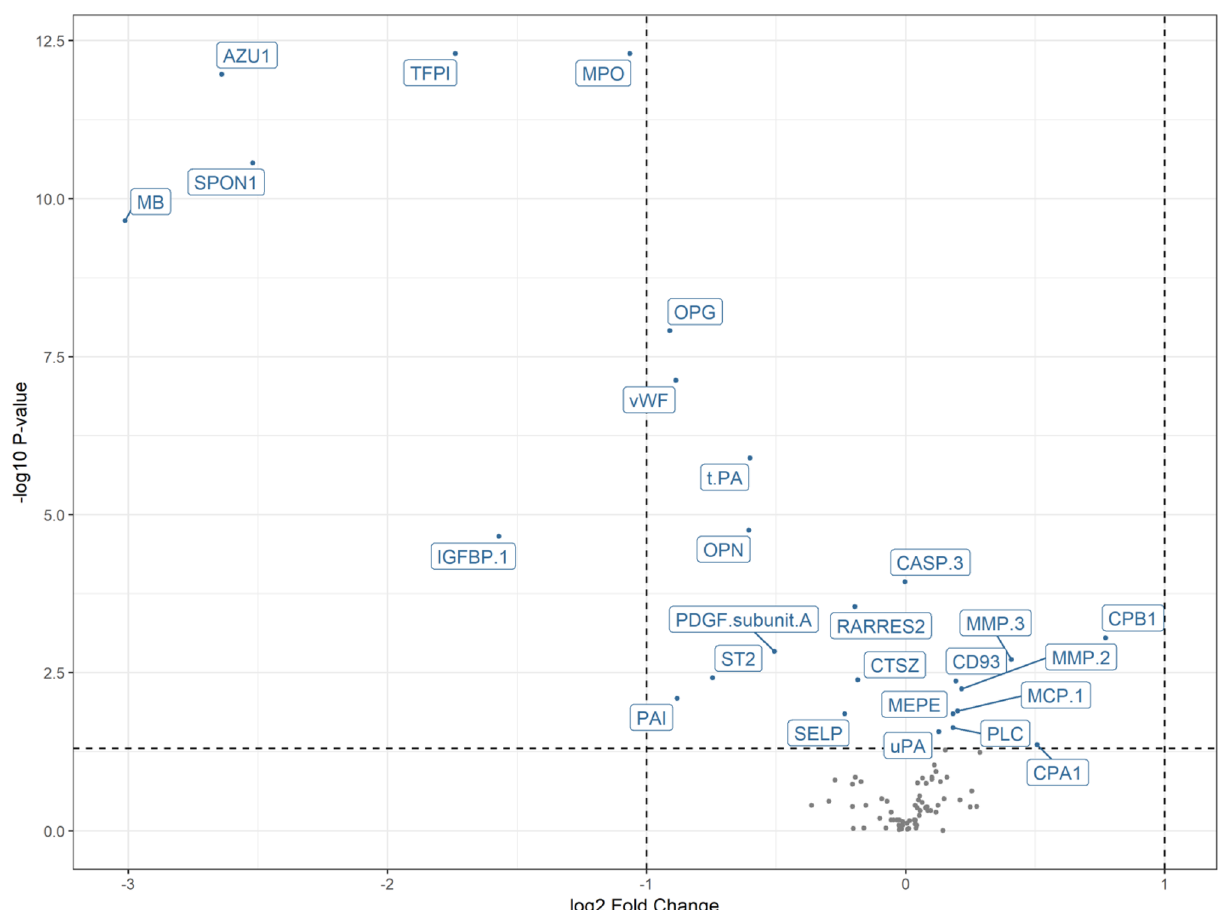
Figure 2. Volcano plot describing the relation between − log10 P-values on the y-axis and log2 fold changes on the x-axis for the 91 proteins. Significant p-values corrected for multiple testing (p < 0.05) are labelled with abbreviated names of the corresponding protein. Horizontal dashed line represents adjusted p-value = 0.05. From left to right, the two vertical dashed lines represent -2 and twofold changes, respectively. This figure was made with the R software package called ggplot2, version 3.3.2: Wickham; ggplot2: Elegant Graphics for Data Analysis. Springer-Verlag New York, 2016: https:// ggplo t2. tidyv erse.